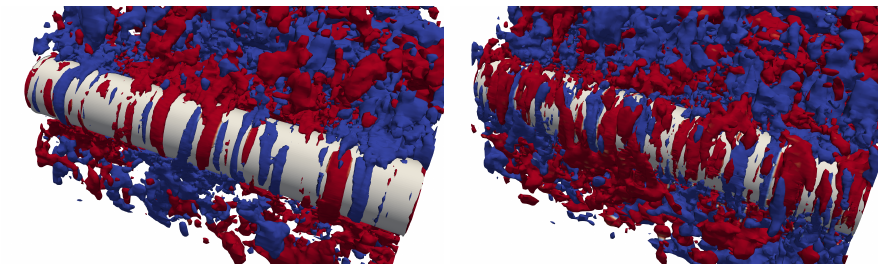
Figure 15. Third and fourth mode span-wise velocity contours ( ± 2.5 × 10 − 5 ).